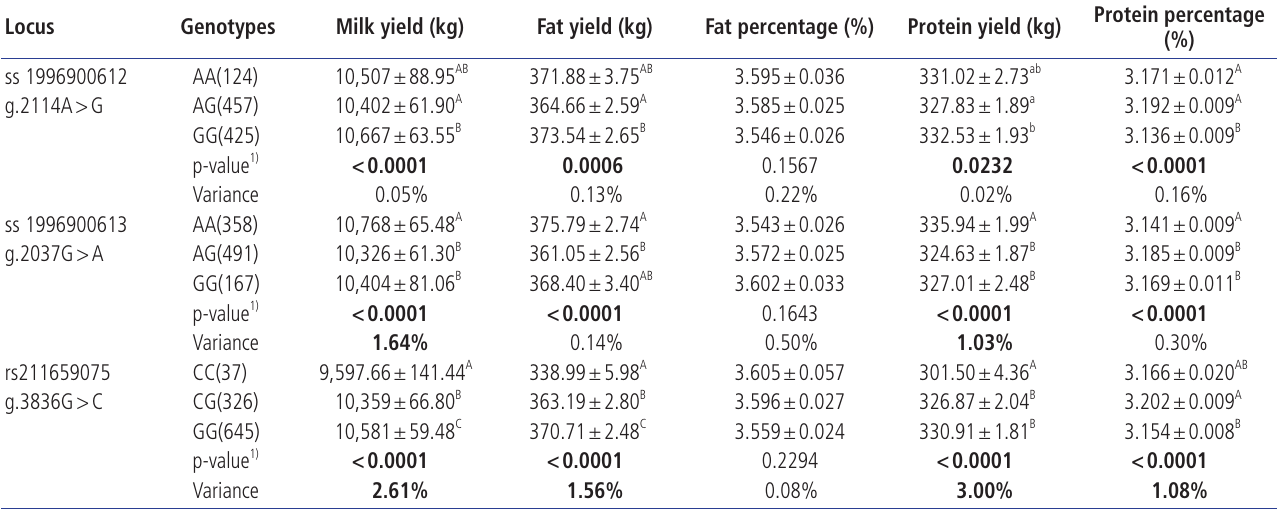
Table 3. Associations of UDP-galactose-4-epimerase single nucleotide polymorphisms with milk production traits in Chinese Holstein cattle (LSM±SE)